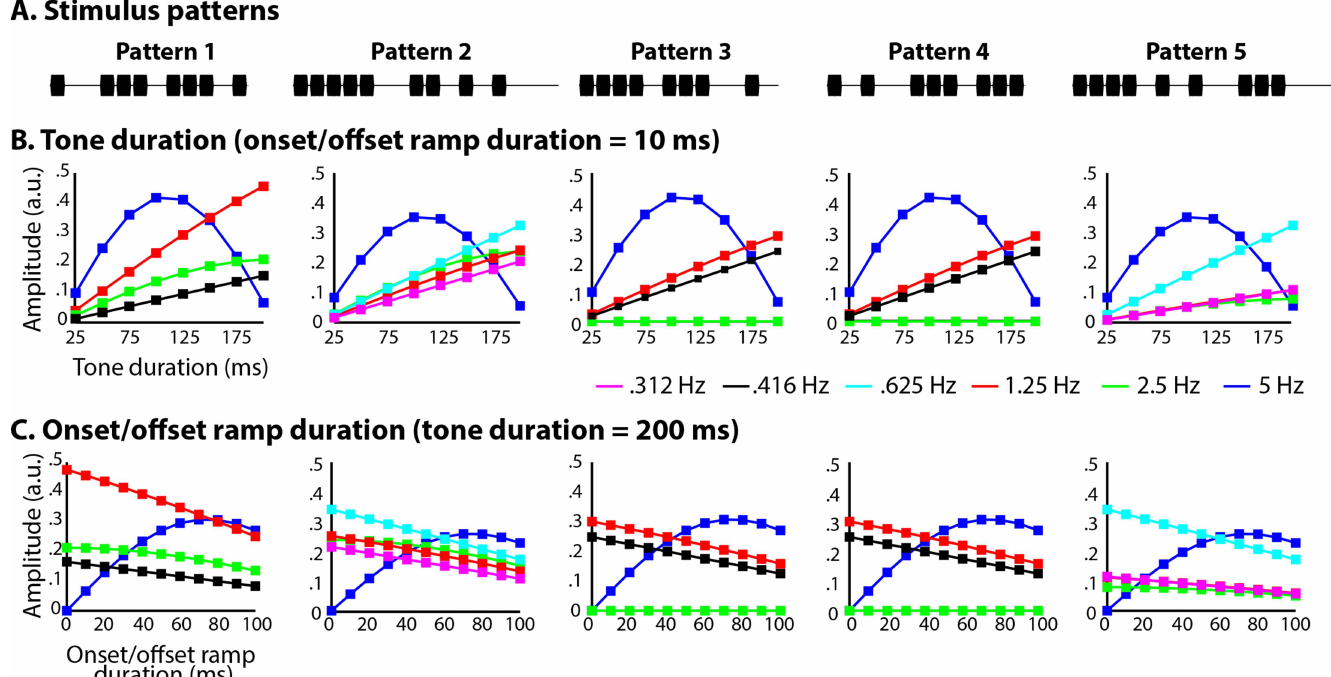
Fig 2. For each of the 5 stimulus patterns used in [44] ( A ), frequency-domain amplitudes at beat-relatedfrequenciesvariedas a function of B) tone duration(onset/offset ramp durationwas fixed at 10 ms) and C) onset/offset ramp duration(tone durationwas fixed at 200 ms), but the functions were different for each frequency and each rhythm. See Supporting Information S1 Fig for all tested combinations of tone durationand onset/offset ramp durationfor all stimulus patterns.